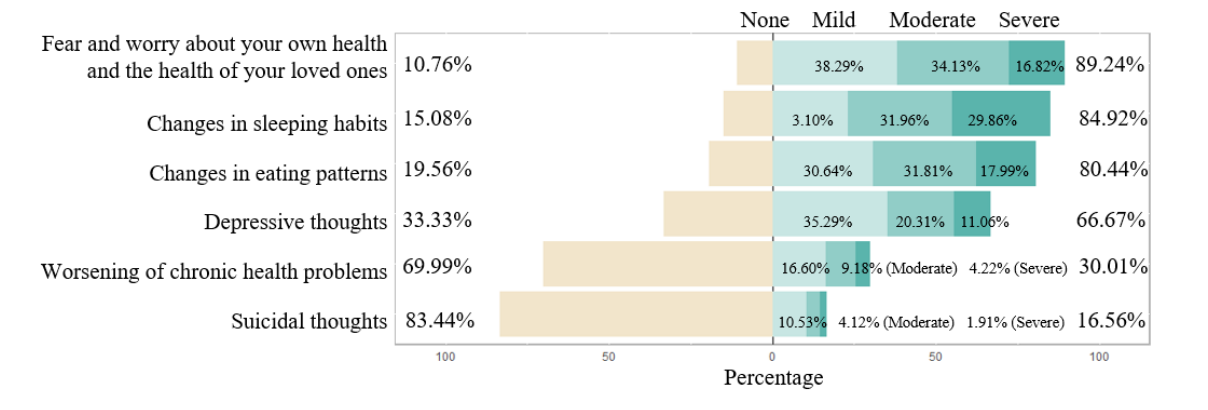
Figure 4. Health-related concerns.